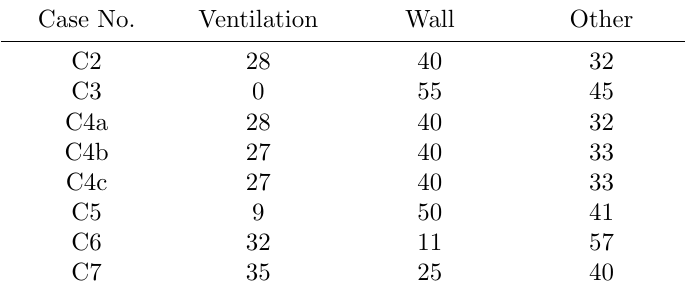
Table 5: Energy losses from the building block as a percentage of total loss Case No.